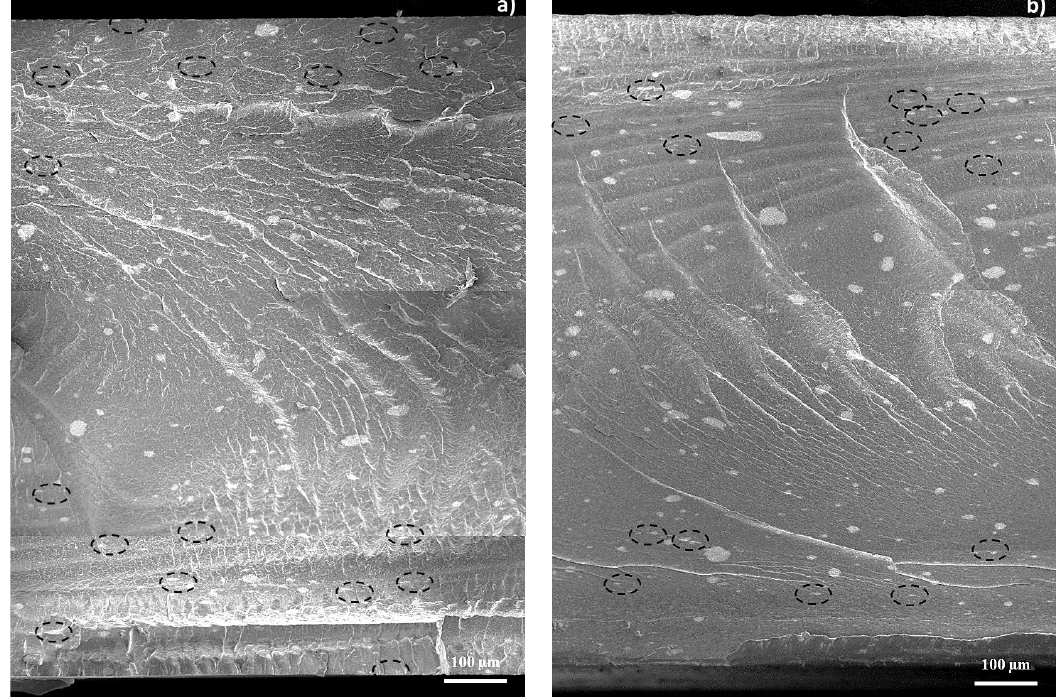
Figure 8. FESEM images of the cross-sectional area of 3%-MWCNT nanocomposites, manufactured at mold temperature 25°C ( a ) and 100°C ( b ), respectively (dashed black circles have been depicted to highlight some of the smaller clusters).